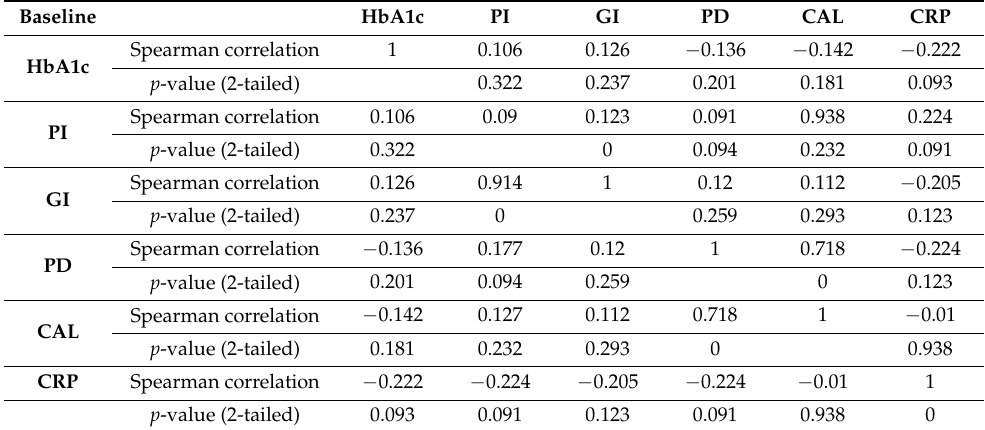
Table 3. Correlation and significance analysis between all the variables of the intervention group at baseline.